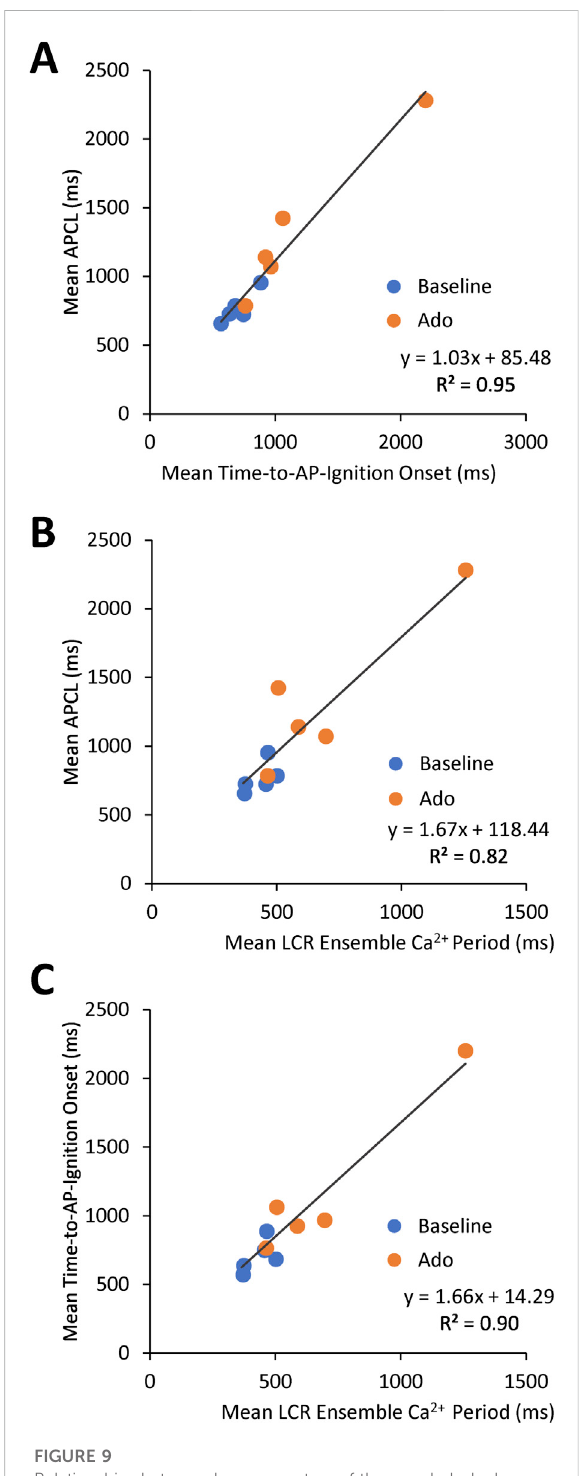
FIGURE 9 Relationships between key parameters of the coupled-clock system in control (baseline) and in the presence of adenosine in SANC in which Ca 2+ and V m were measured simultaneously. The LCR period informs on the APCL because the LCR period informs on the time-to-AP-ignition onset. Both Time-to-AP- ignitiononset (A) andLCRperiod (B,C)